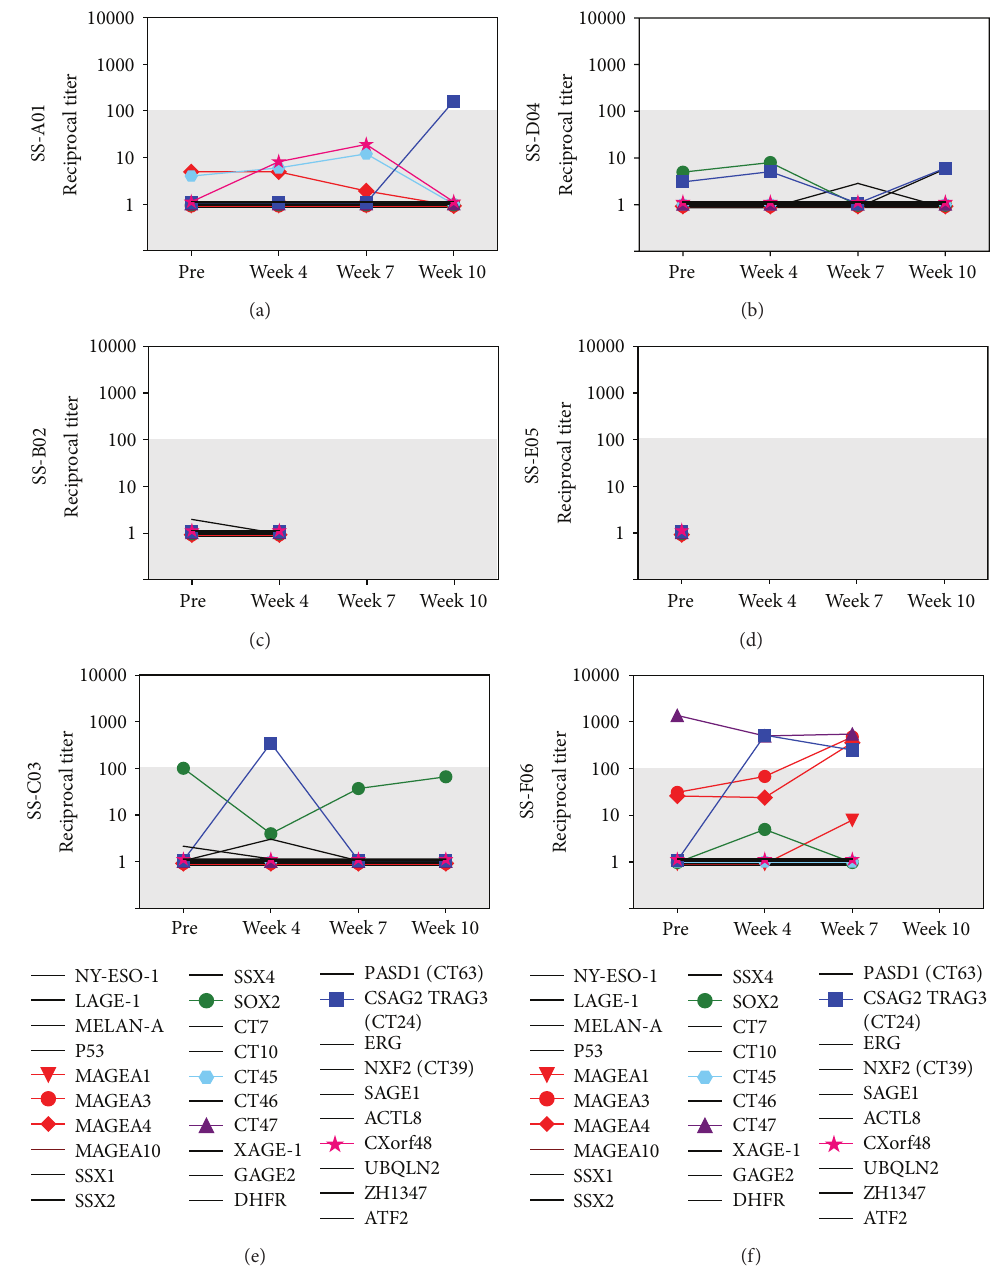
Figure 1: One study patient demonstrated an immune response to a CTA after ipilimumab administration. Plots demonstrating immune titers in each patient to the specified CTA before ipilimumab and at weeks 4, 7, and 10 are presented. Only patient SS-F06 reproducibly showed a weak preexisting serum antibody response to MAGEA3 and MAGEA4, that increased after treatment. Patient SS-F06 also had serum antibodies to CT47 throughout the study that did not change in titers and seroconversion against CSAG2 after the first ipilimumab injection. Patient SS-C03 had some reactivity to SOX2 and had a transient response to